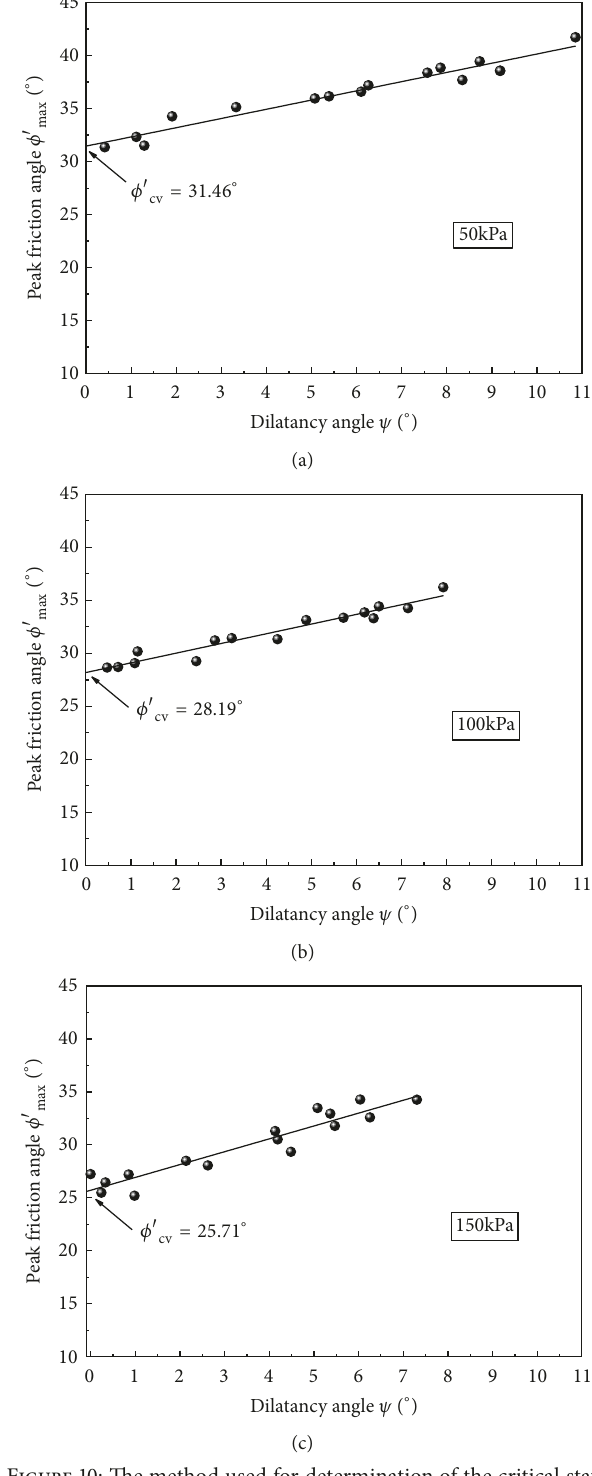
Figure 10: The method used for determination of the critical state friction angle. (a) 50 kPa; (b) 100 kPa; (c) 150 kPa.